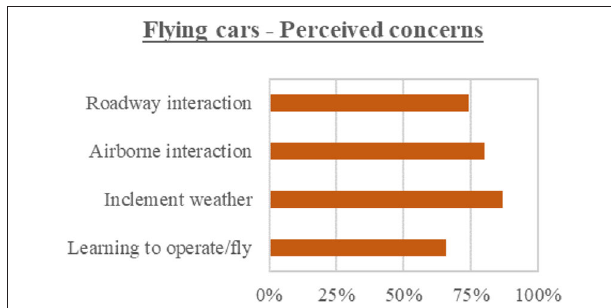
FIGURE 8 | Willingness to hire.